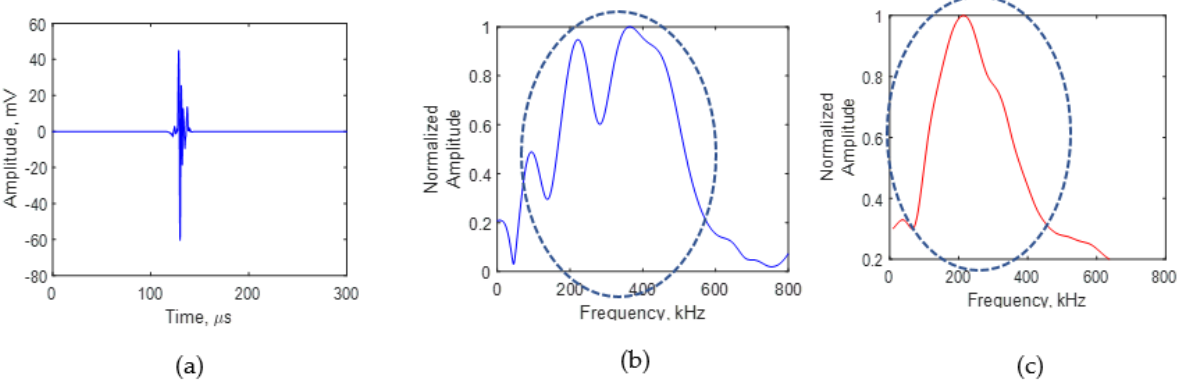
Figure 10. AE signal at a crack length of 4 mm: ( a ) experimental signal recorded using the PWAS sensor; ( b ) experimental frequency spectrum; ( c ) simulation frequency spectrum.